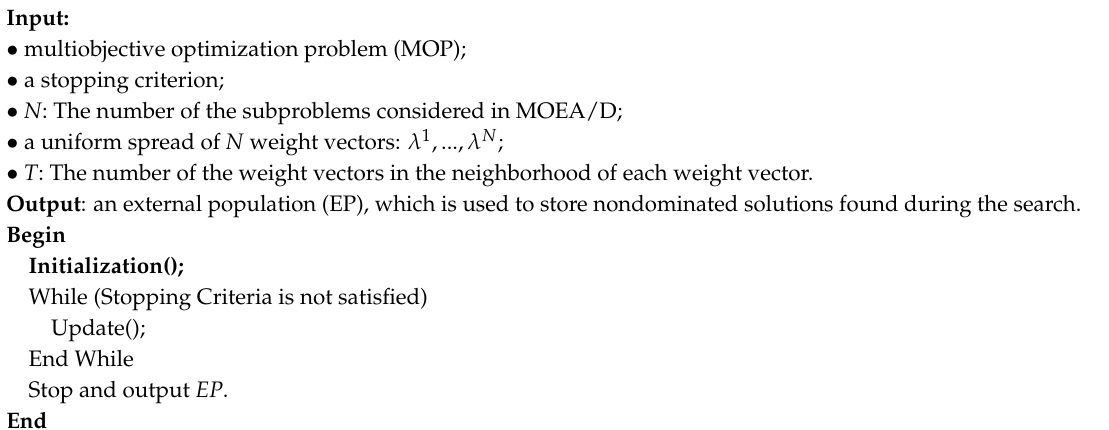
Algorithm 3. MOEA/D